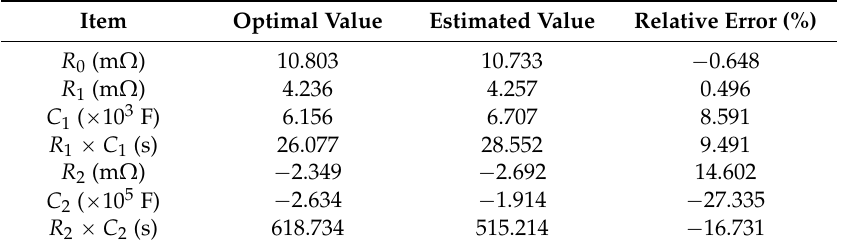
Table 2. Verification result.